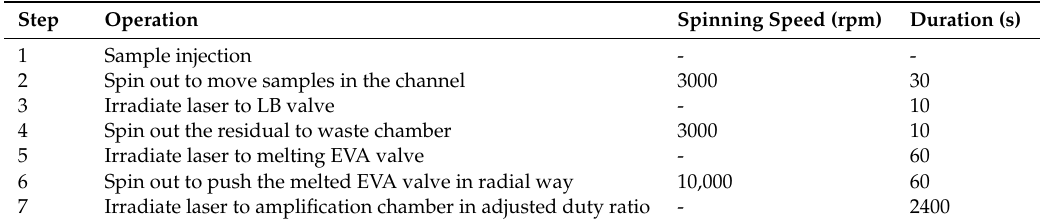
Table 1. Disc driving sequence of the loop-mediated isothermal amplification (LAMP) reaction.